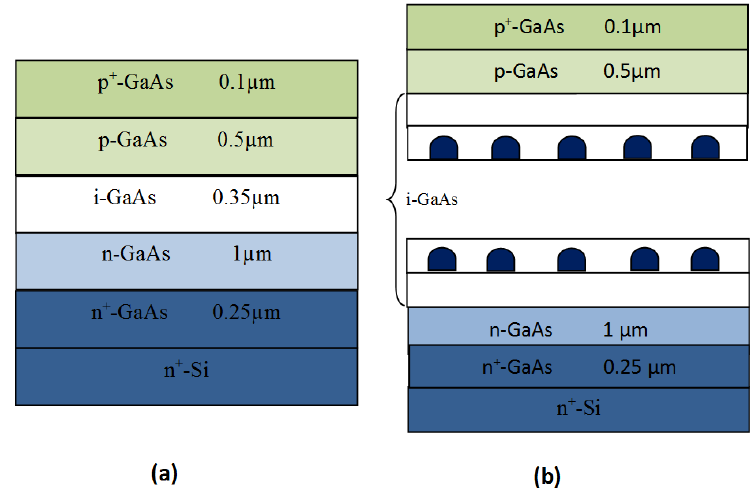
Figure 1. Schematic presentation of the investigated samples. ( a ) pin-GaAs/Si; ( b ) pin-GaAs/Si containing 40 QD